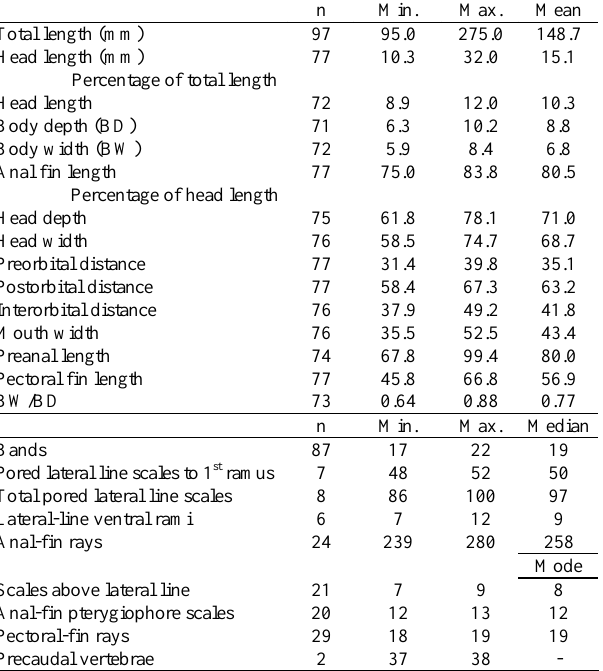
Table 2. Morphometric and meristic data for Gymnotus chaviro . BW/BD expressed as a ratio.